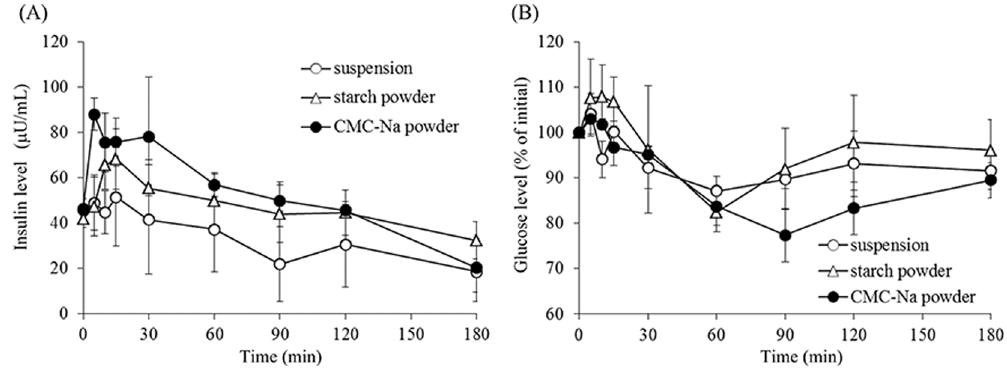
Fig 2. The plasma level of (A) insulin and (B) glucose after nasal administration of various insulin formulations to rats. Keys; (cid:4) , suspension; 4 , starch powder; ● , CMC-Na powder. Results are expressed as the mean ± S.E. of at least three